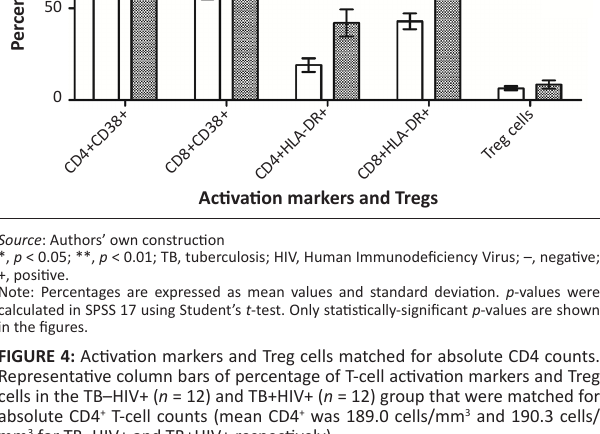
FIGURE 4: Activation markers and Treg cells matched for absolute CD4 counts. Representative column bars of percentage of T-cell activation markers and Treg cells in the TB–HIV+ ( n = 12) and TB+HIV+ ( n = 12) group that were matched for absolute CD4 + T-cell counts (mean CD4 + was 189.0 cells/mm 3 and 190.3 cells/ mm 3 for TB–HIV+ and TB+HIV+